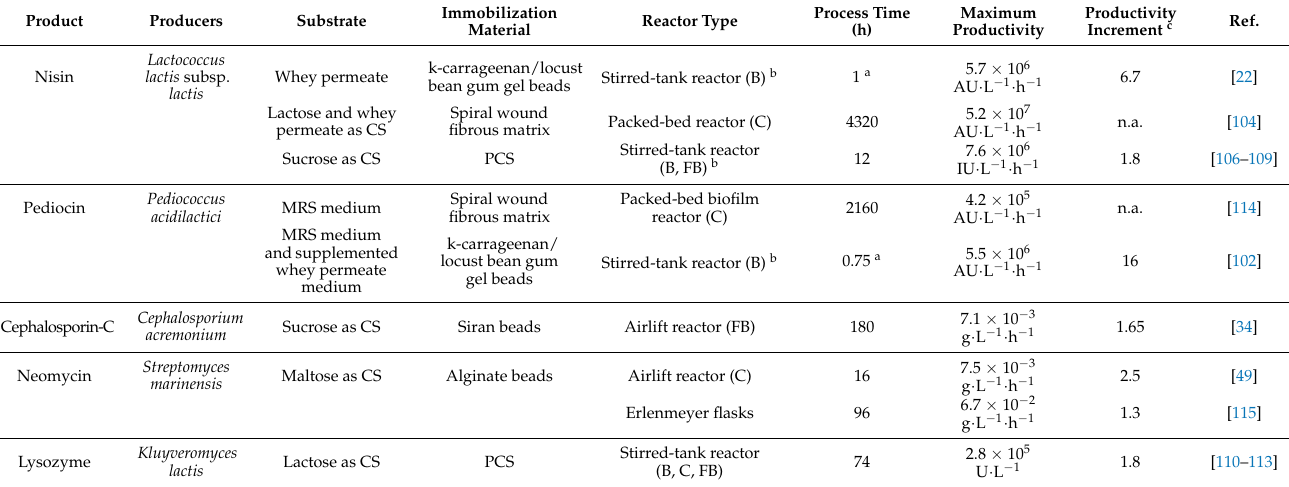
Table 4. Different classes of antimicrobial compounds produced in biofilm